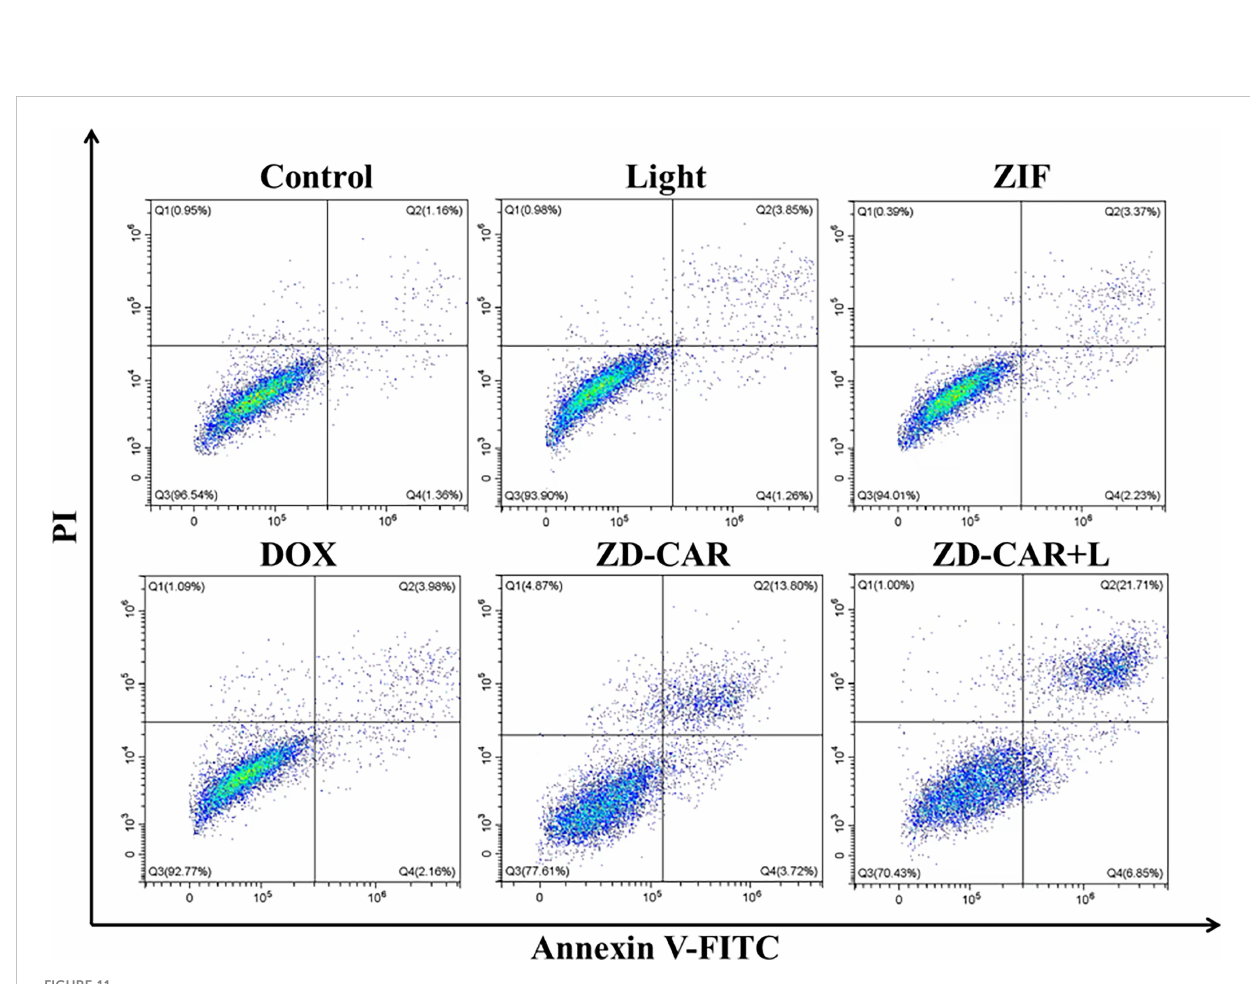
FIGURE 11 Flow cytometric after treating HepG 2 cells in different ways using Annexin V-FITC staining (incubated for 24 hours on wall and 6 hours after addition of NPs).